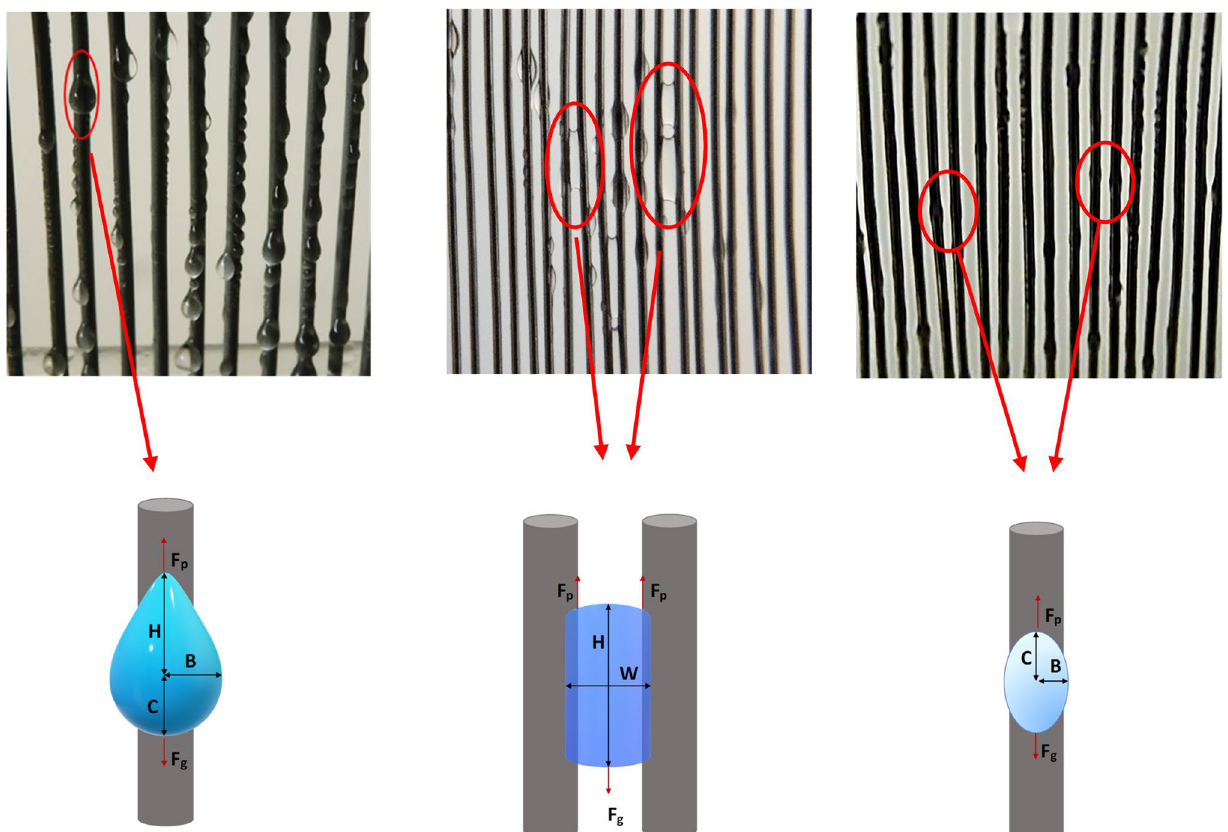
Fig. 5 The drop and barrel shape of the sliding droplets on the W1.5-2 (left), W0.5-2 (middle), and W0.5-2E (right) collectors and their cor- responding